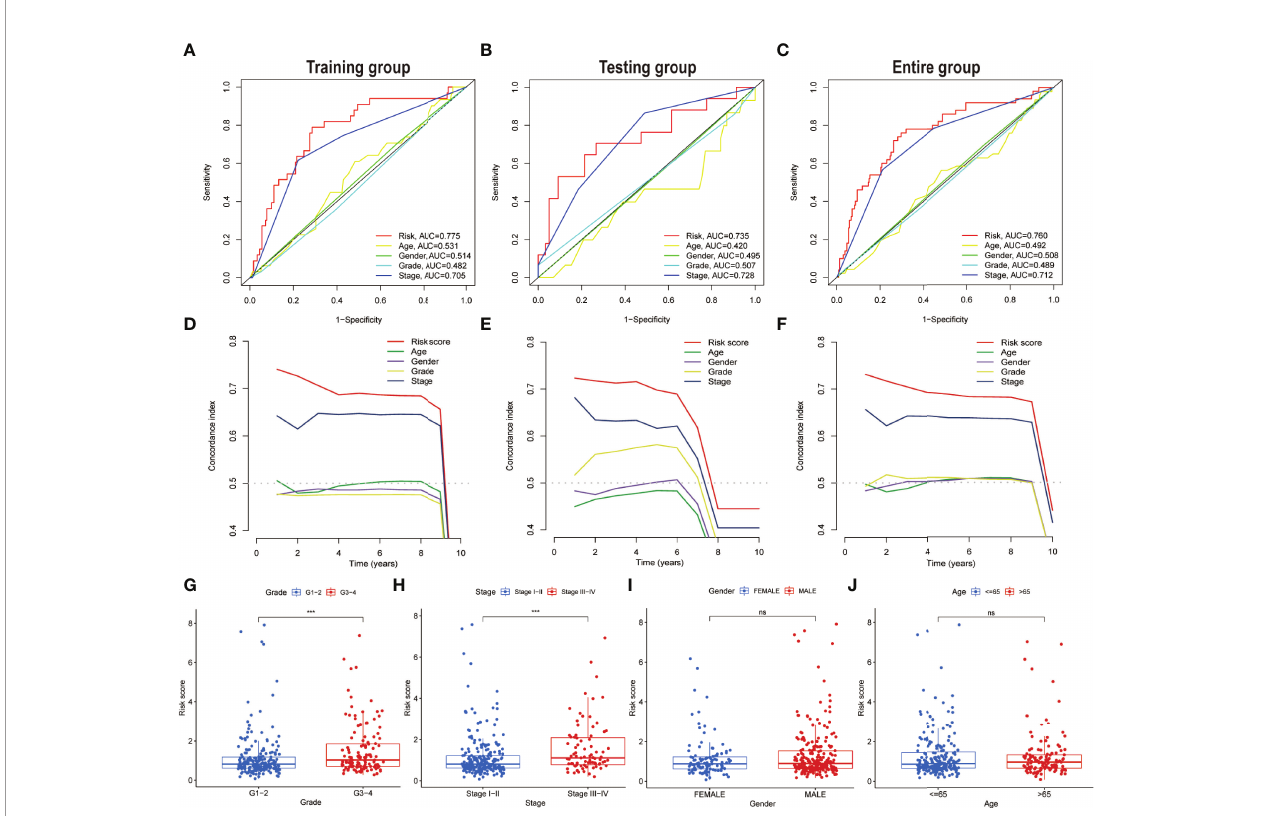
FIGURE 6 | Comparing the prognostic precision of the model and clinical features and comparing risk scores between subgroups with different clinical characteristics. (A – C) Prognostic accuracy of the risk scores, age, gender, grade, and tumour stage were compared using time-dependent ROC curves in the time duration of 1 year. (D – F) The concordance index was used for comparing the discrimination of the model, age, gender, grade, and tumour stage in three datasets. Risk scores are grouped by different clinical characteristics in the entire set. (G) Grade. (H) Stage. (I) Gender. (J) Age. ns, no signi fi cance; ***P <